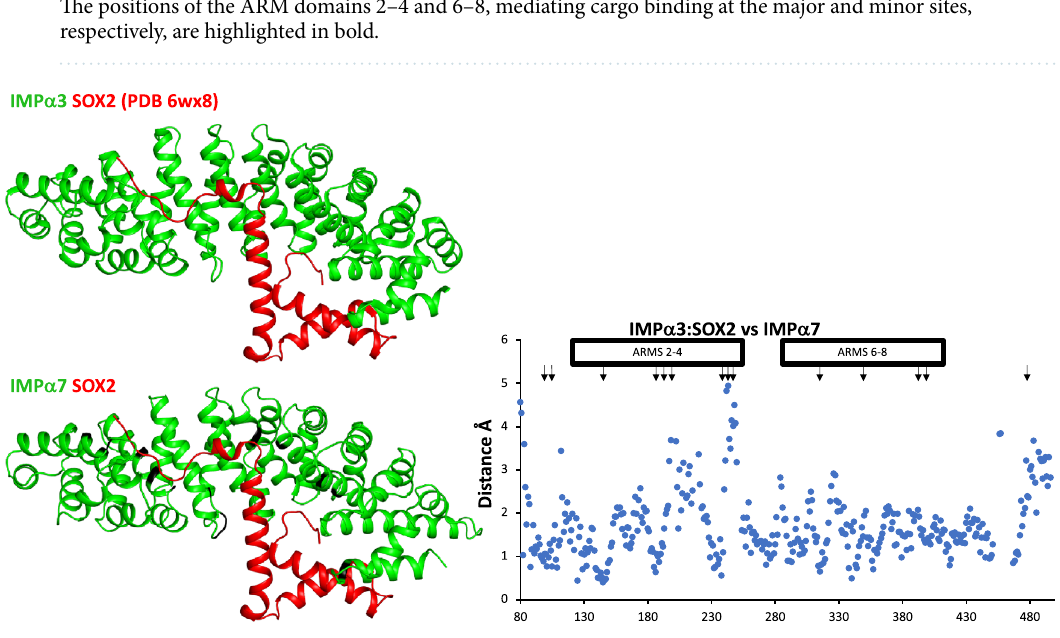
Figure 4. Structural alignment of unbound IMPα7 with IMPα3 in complex with SOX2 (PDB 6WX8). Phenix validation was used to analyze clash data. IMPα7 with merged SOX2 produced clashscore value of 20.7. The positions of clashing residues of IMPα7 are highlighted in black. Clashes are also presented in the graph, with clashes > 0.8 highlighted with black